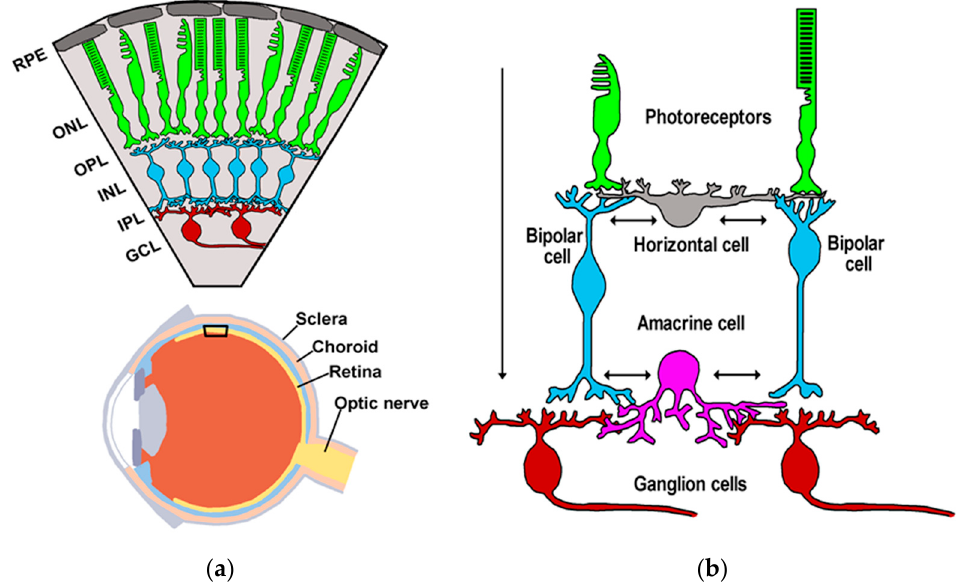
Figure 1. Retinal circuitry: ( a ) Scheme of the eye and sectional view of the layered retina structure. Only the three main classes of principal neurons—photoreceptors (green), bipolar cells (light blue), and ganglion cells (red)—are shown. RPE, retinal pigment epithelium; ONL, outer nuclear layer; OPL, outer plexiform layer; INL, inner nuclear layer; IPL, inner plexiform layer; GCL, ganglion cell layer. ( b ) Schematic drawing of the information flow in retina. Cone and rod photoreceptors send signals to bipolar cells, which, in turn, affect the activity of ganglion cells. The axons of ganglion cells form the optic nerve. Horizontal cells (gray) and amacrine cells (purple) modulate signal transfer across synaptic stations (OPL and IPL). The arrows indicate the vertical and lateral information flows.